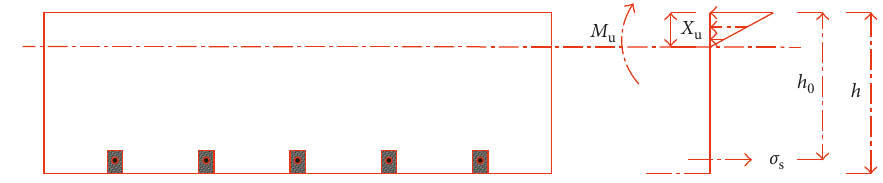
Figure 53: The stress profile of the cross section of the stone slab with the ultimate moment.